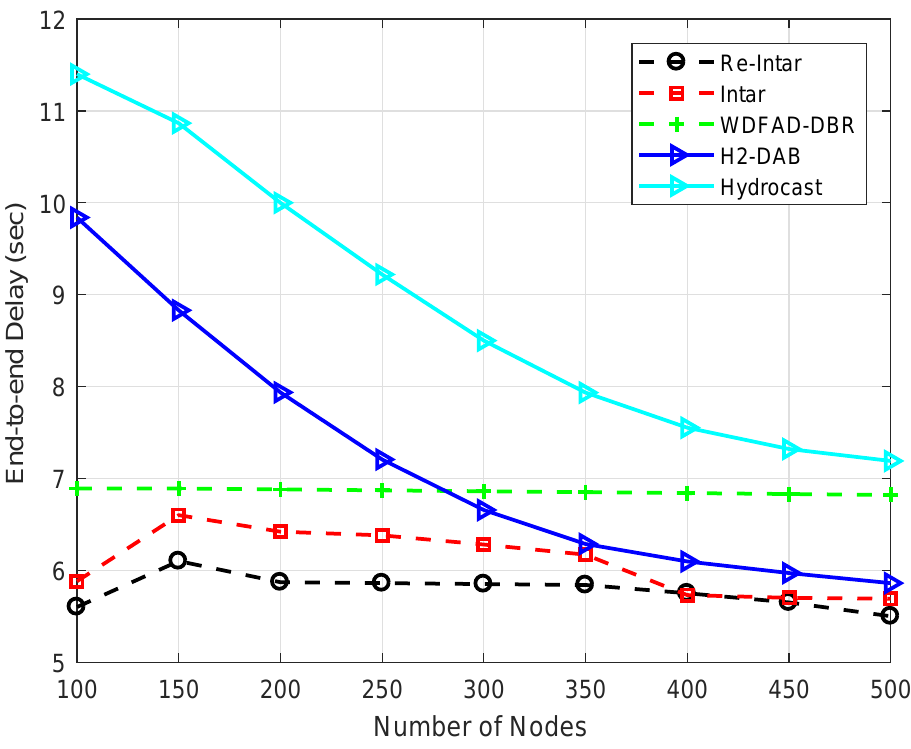
Figure 6. End-to-end delay of the existing and proposed protocols with varying number of